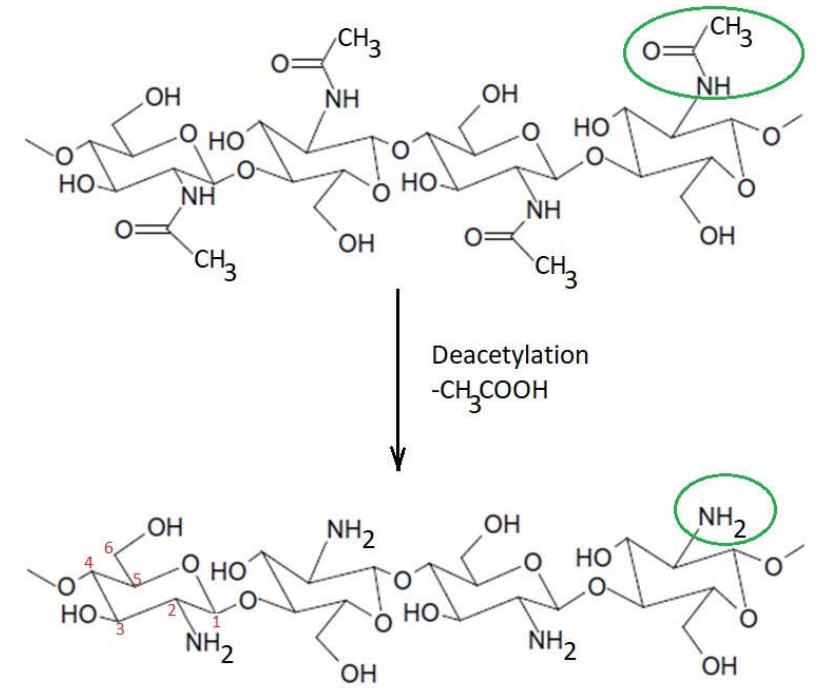
Figure 4. Difference between the structures of chitin and chitosan.